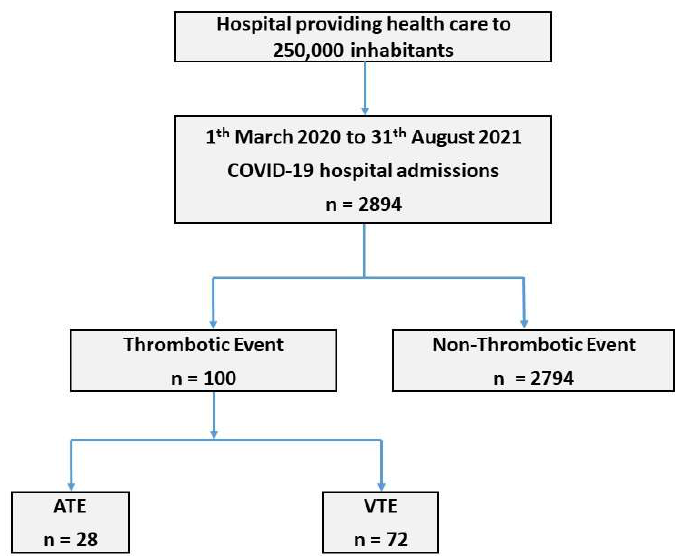
Figure 1. Flowchart of Patient Enrollment. ATE: arterial thrombotic event; VTE: venous thrombotic event.